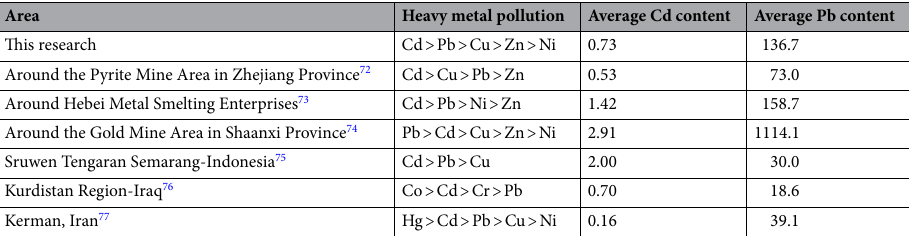
Table 8. Comparison of heavy metal pollution in farmland soil in different regions (mg kg −1